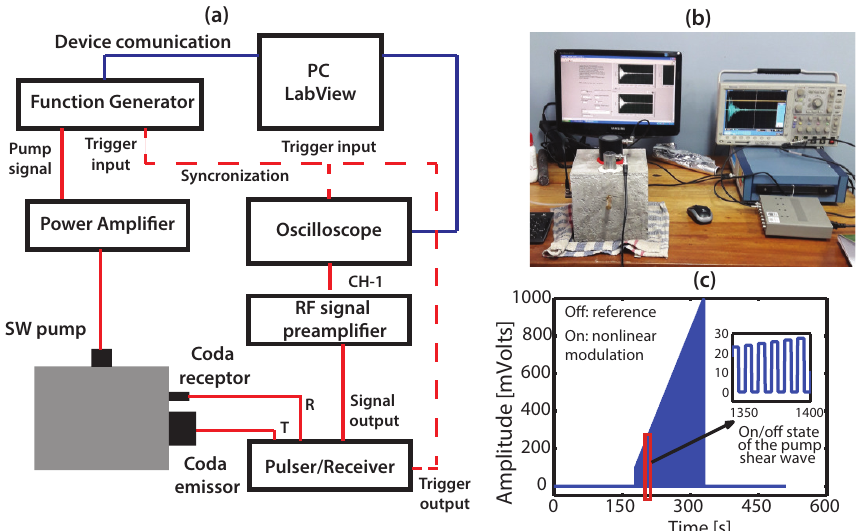
Figure 4. Nonlinear Coda Wave Interferometry technique. ( a ) Experimental NCWI devices configura- tion schema. ( b ) Image of the NCWI experiment with the cubic concrete sample for device settings performance (same concrete sample than Figure 3). ( c ) SW pump-wave amplitude